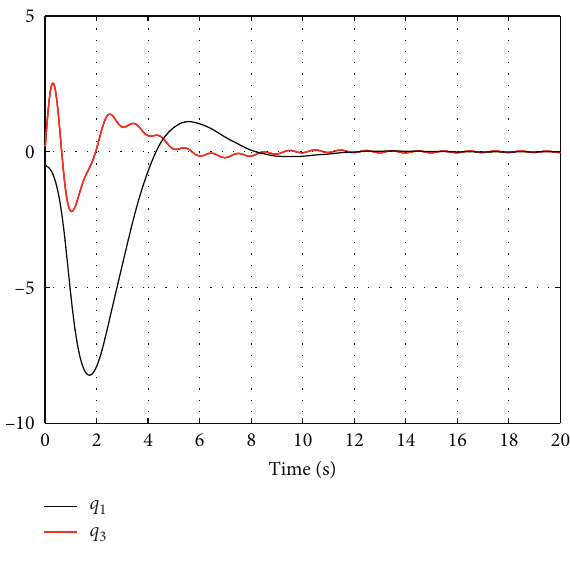
Figure 6: DIP response without perturbation.